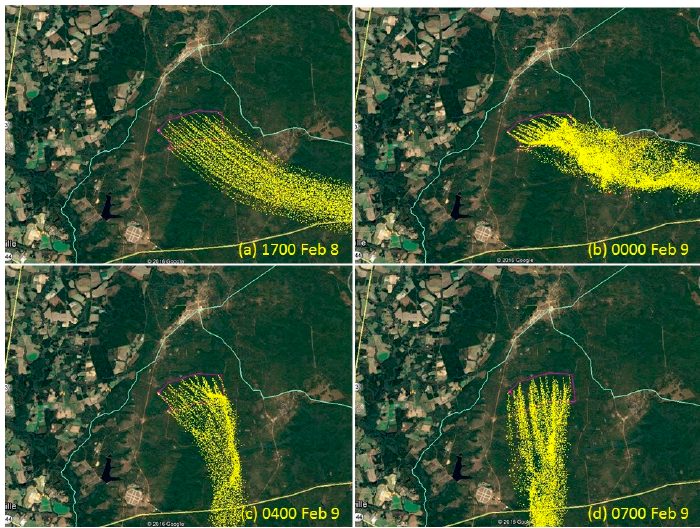
Figure 10. PB-P simulation of smoke during night of 7 February 2011 at four times ( a – d ). Yellow indicates smoke particles. The pink area is the hypothetical burn site of Block 3. The winds blow from the northwest at 1700 LST, 8 February (Figure 11a). By midnight (Figure 11b), the winds are still blowing from the northwest albeit with reduced speeds. The plume is distorted by the surrounding terrain; however, there is no indication of drainage flow entrapment. The winds have shifted to blow from the north by 0400 LST, 9 February (Figure 11c). There is some evidence for valley steering of the plume as suggested by the bright band of particles. The winds continue blowing from the north for the remainder of the night (Figure 11d). The plume of particles near the ground blows across highway SR-144. Conditions never become favorable for collocation of fog.